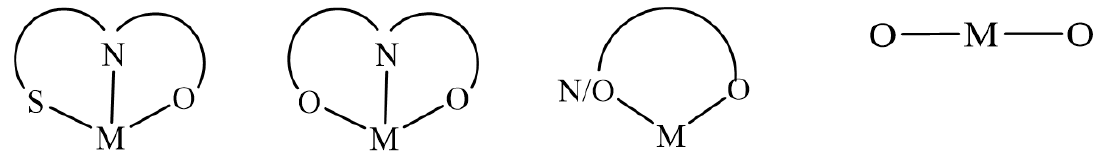
Figure 13. Coordination modes for the chromones complexes.